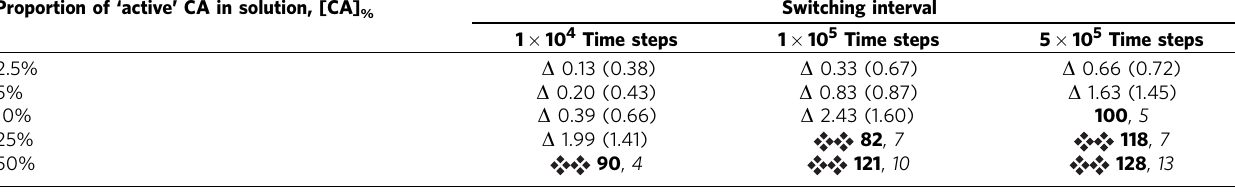
Table 3 | CG self-assembly for varying [CA] % , (see the main text) with 4mM total CA and 200 mgml (cid:2) 1 of inert crowder. Proportion of ‘active’ CA in solution, [CA] %